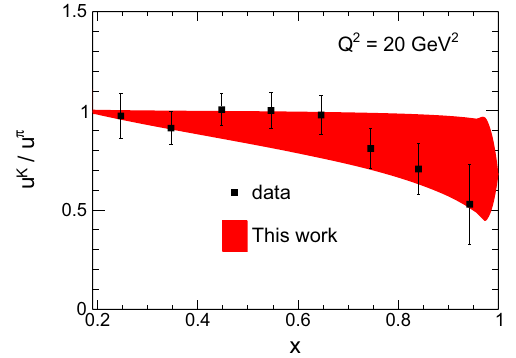
Fig. 3 Comparisons of our predicted ratio u K / u π as a function of x with CERN-NA3 experimental data [25]. The error band of this work shows the 3 σ uncertainty of the